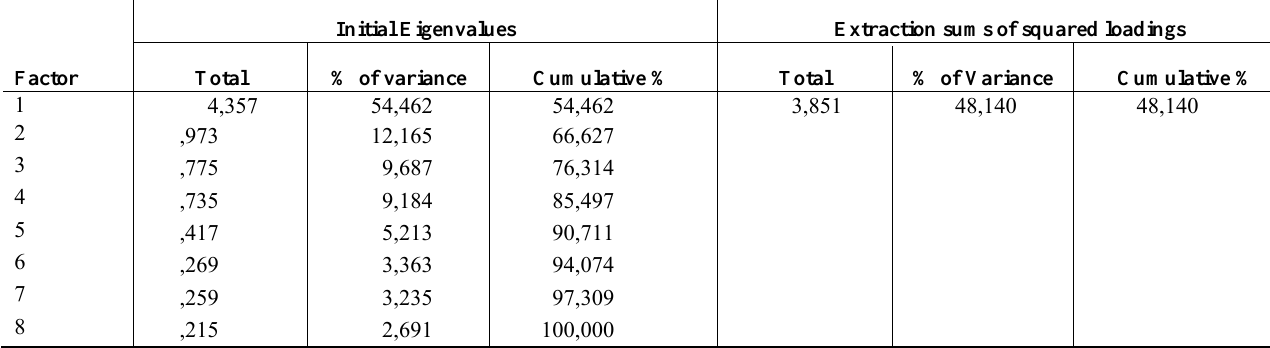
Table 5: Total variance explained